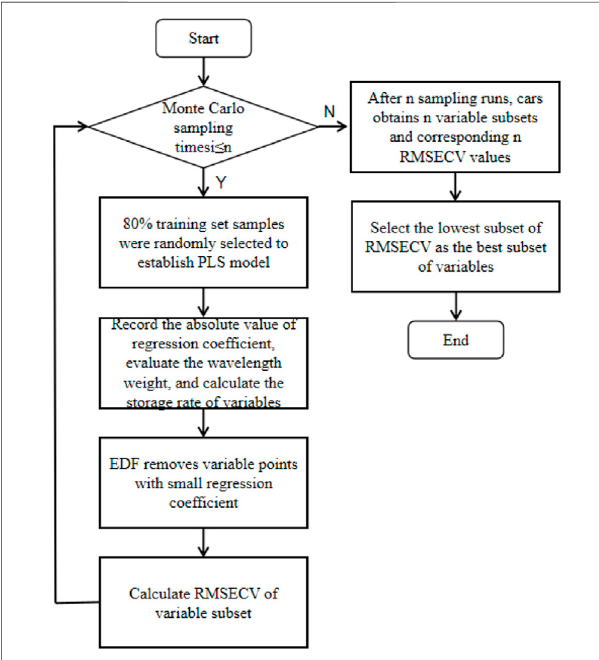
FIGURE 9 | CARS algorithm